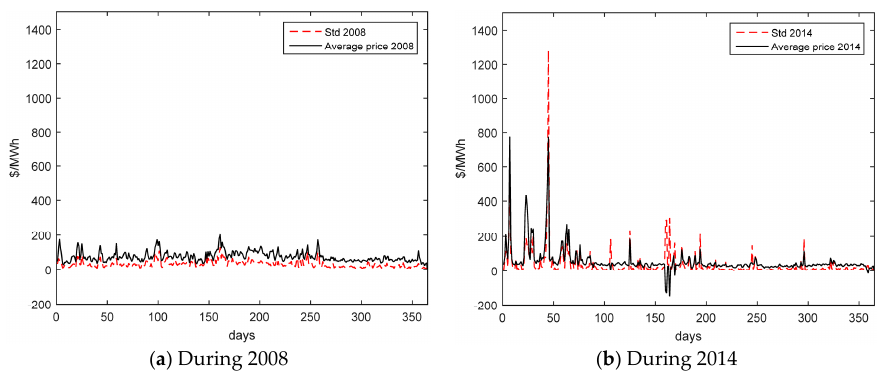
Figure 7. Daily-based standard deviation (Std) and the mean value of real-time prices at the price node NEWMERED69 KV N-MERD.